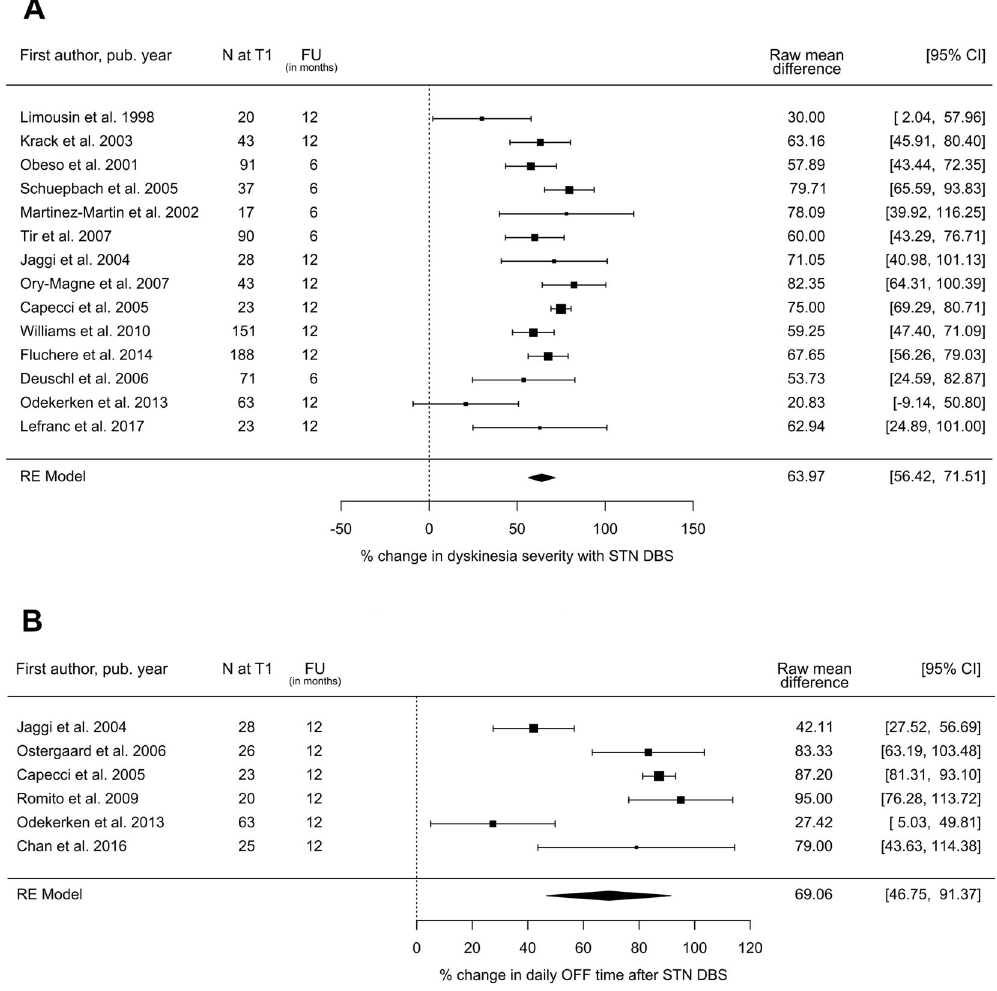
Fig. 6 Change in motor complications following STN-DBS. Postoperative vs. preoperative state: change in mean dyskinesia severity ( A ) and mean OFF time ( B ). N = number of subjects at follow-up; FU = follow-up time; CI = con fi dence interval; RE Model = random-effects